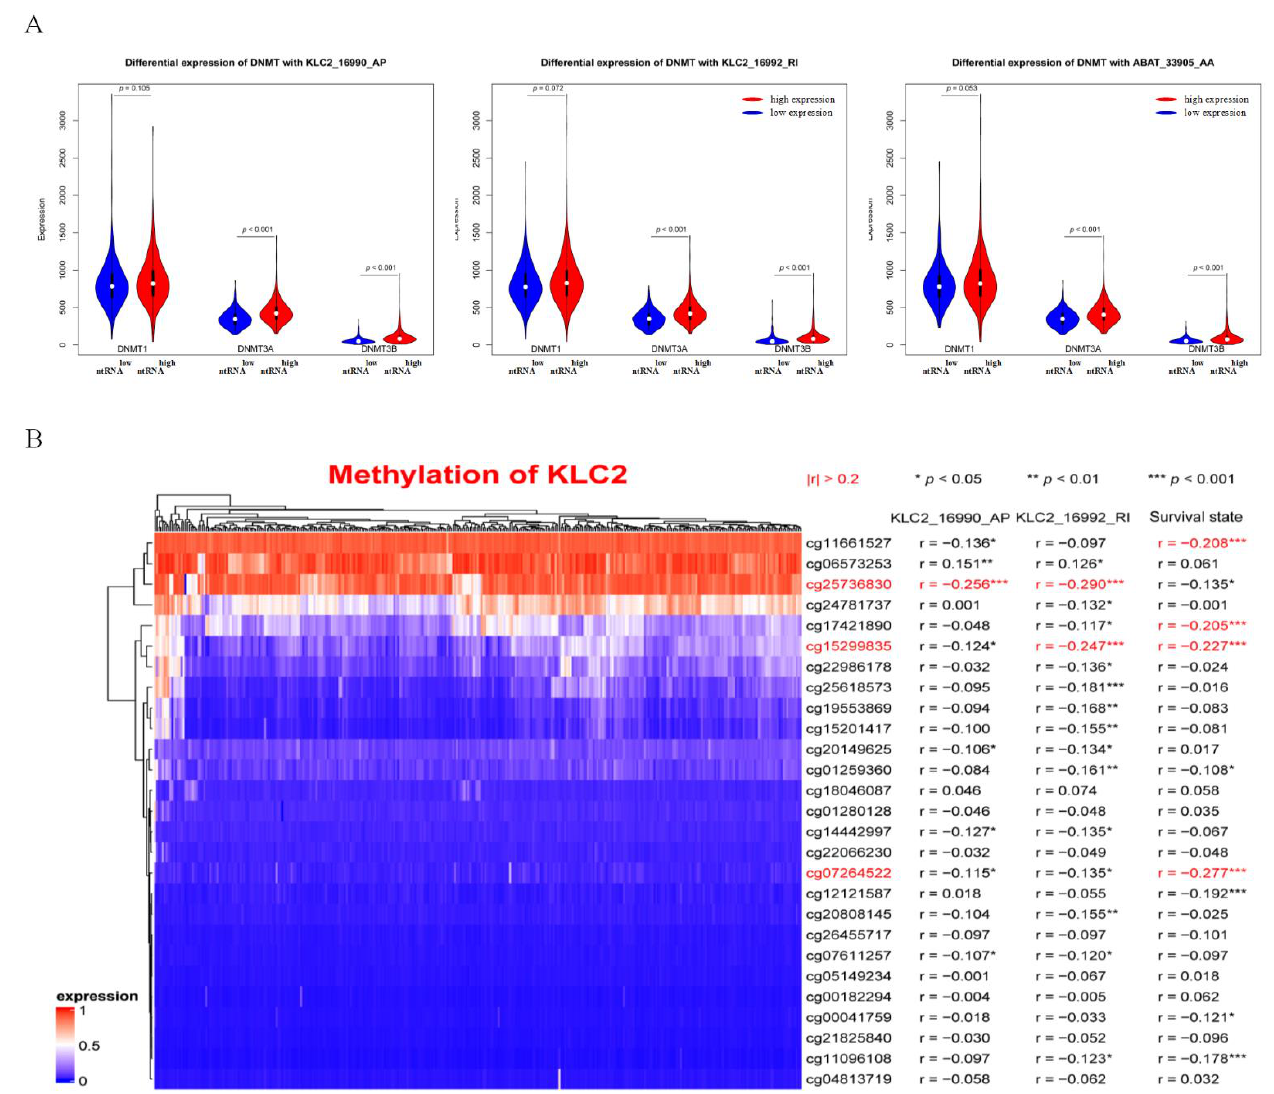
Figure 6. Analysis of ntRNA methylation. ( A ) Differential expression of three DNA methyltrans- ferases (DNMT1, DNMT3A, and DNMT3B) with three ntRNAs (KLC2_16990_AP, KLC2_16992_RI, and ABAT_33905_AP). ( B ) Heatmap of methylation probes of KLC2.